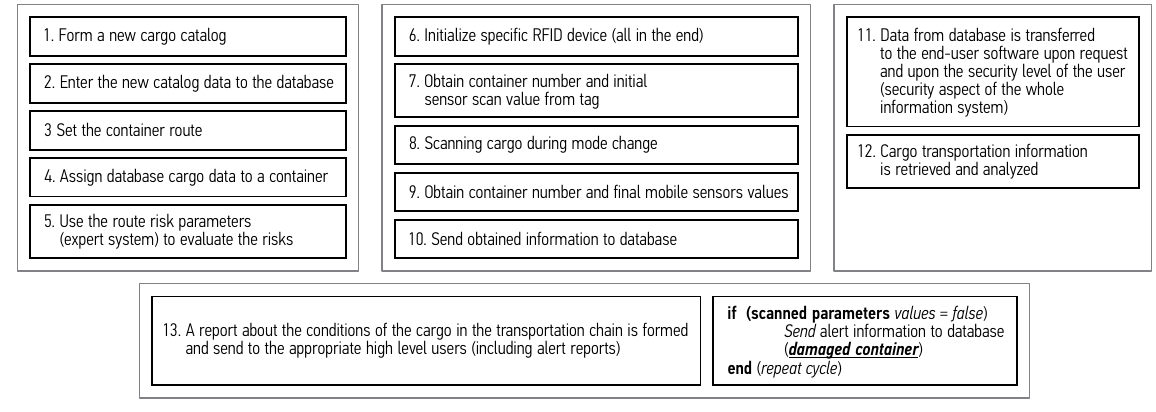
Fig. 2. Overall CIS functionality